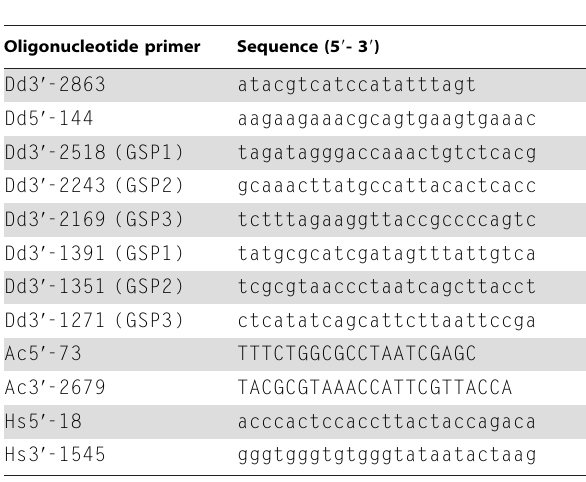
Table 1. Oligonucleotide primers used to detect and map rRNA cleavage